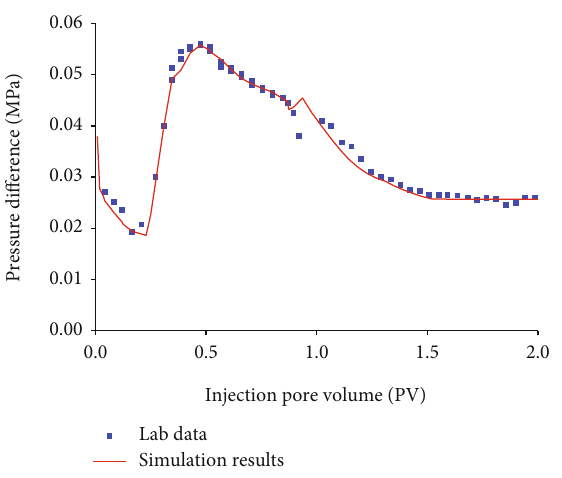
Figure 3: Comparison of pressure di ff erence between experiment data and model